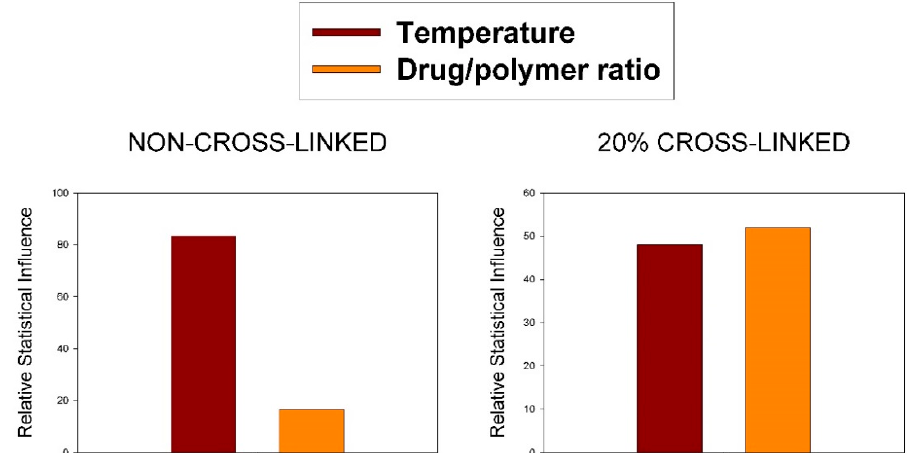
Figure 2. Relative influence of the studied variables on encapsulation efficiency (EE%) in non-cross- linked and cross-linked nanoparticles.